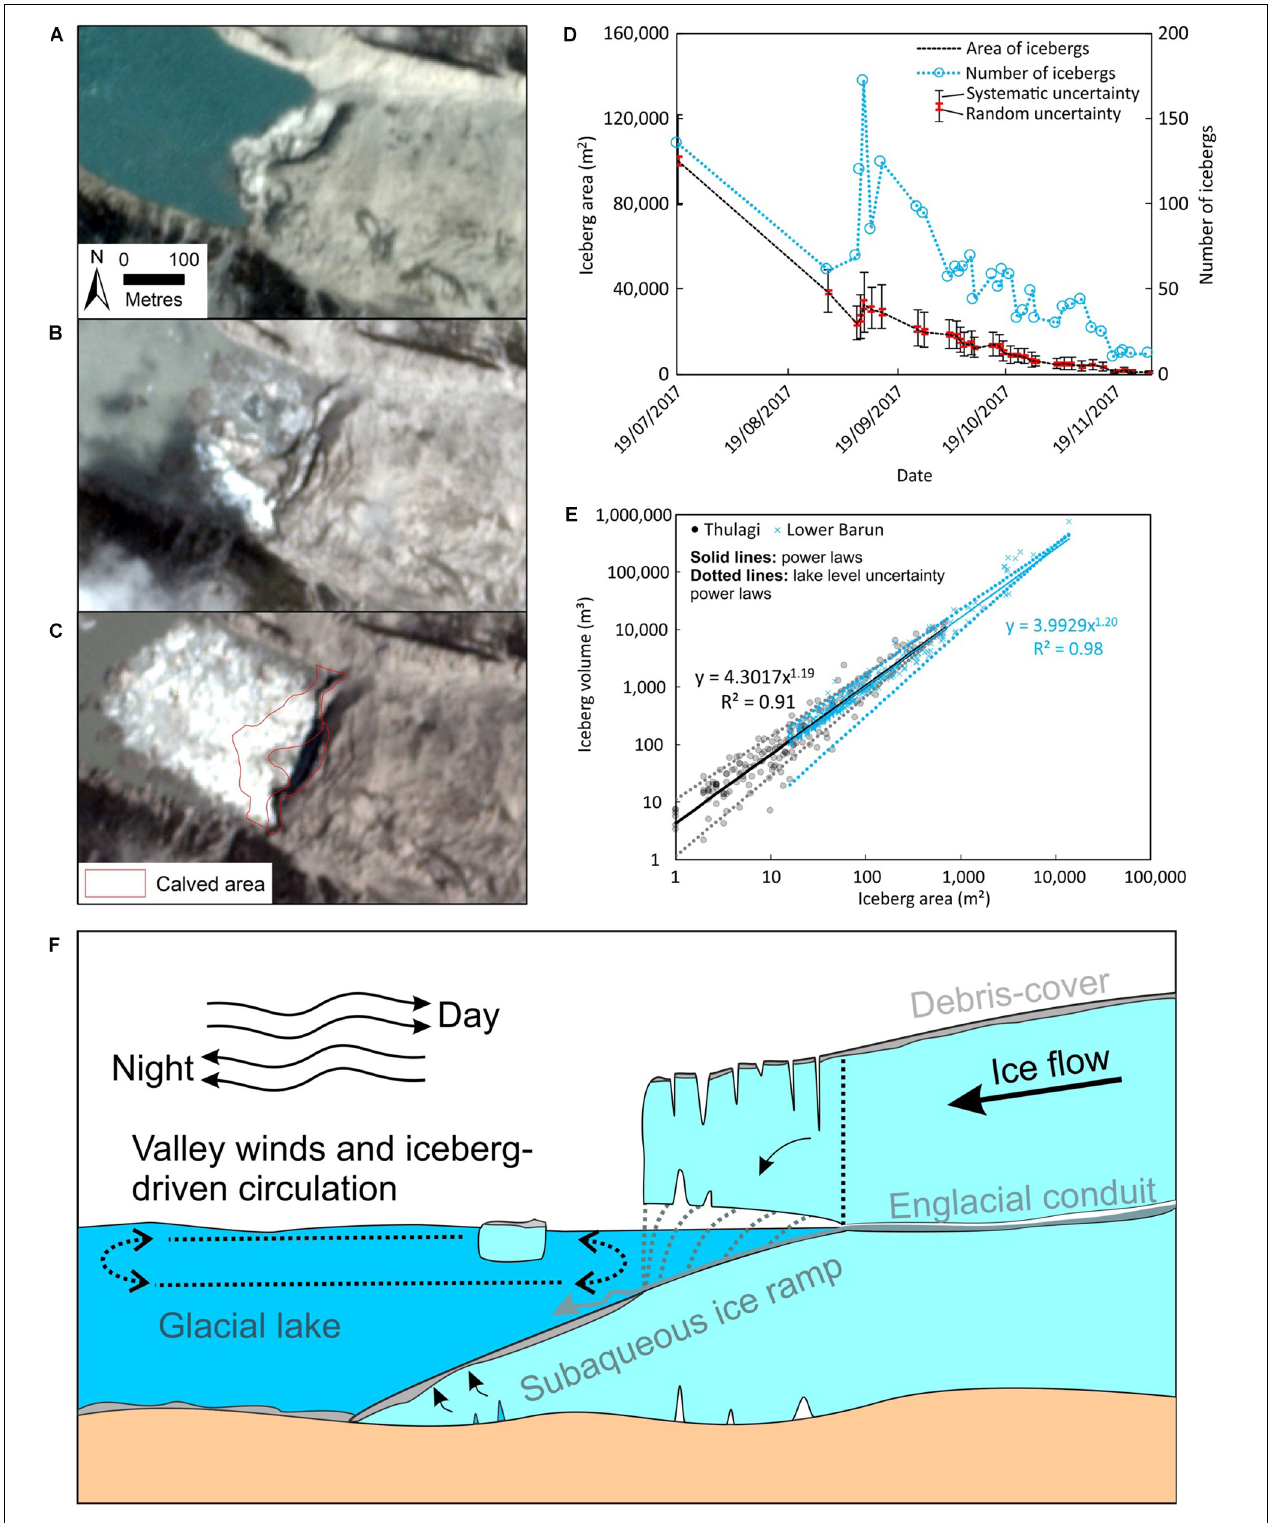
FIGURE 3 | PlanetScope satellite image showing (A) the calving front of Thulagi Glacier on 16 April 2017, (B) 7 September 2017 and (C) post-calving (second event) 9 September 2017. (D) Area and number of icebergs on Thulagi Lake classified using PlanetScope imagery. (E) The relationship between planimetric iceberg area and total iceberg volume derived at Thulagi ( n = 181) and Lower Barun ( n = 389) lakes. (F) Conceptual diagram of glacier calving.